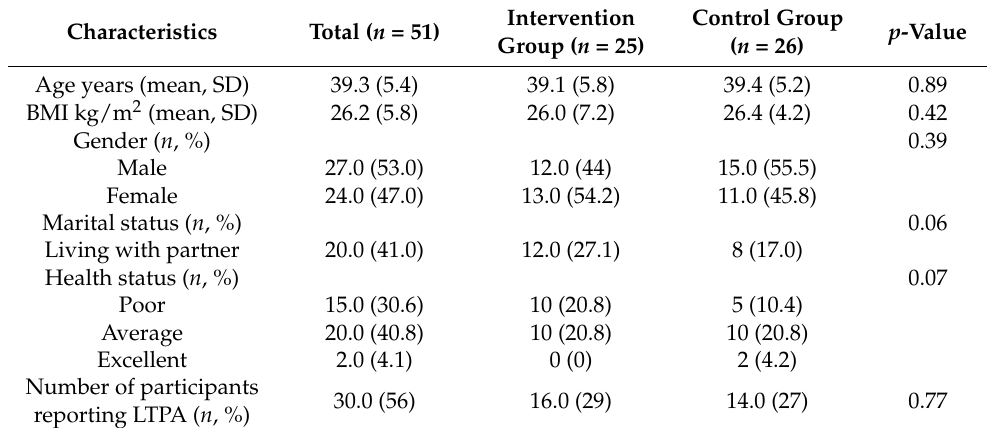
Table 2. Baseline characteristics of participants in the intervention and control groups [mean, n (%)].